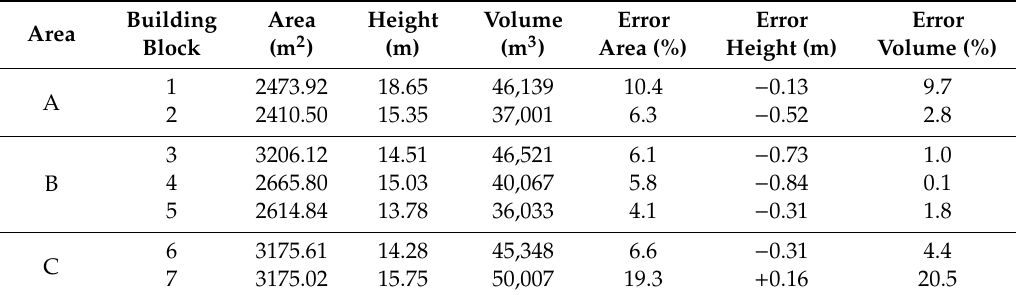
Table 1. Building block parameters (area, height and volume) estimated from unmanned aerial vehicle (UAV) and the error obtained in this